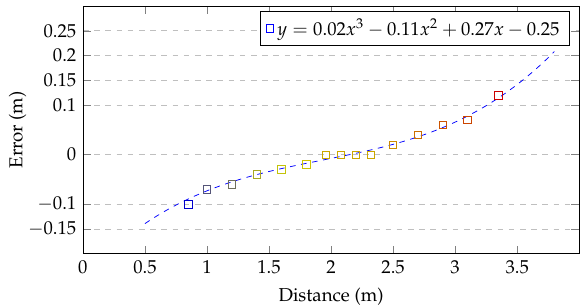
Figure 2. Microsoft Kinect depth measurement accuracy as a function of Kinect–joints